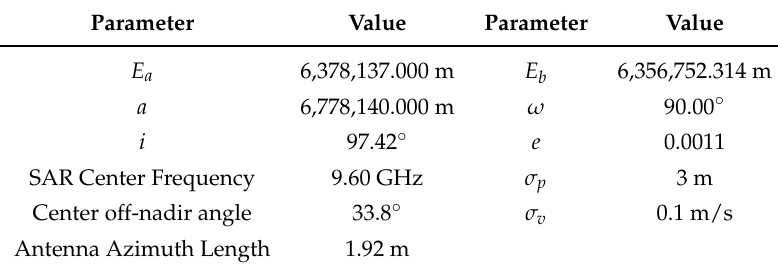
Table 1. Simulation